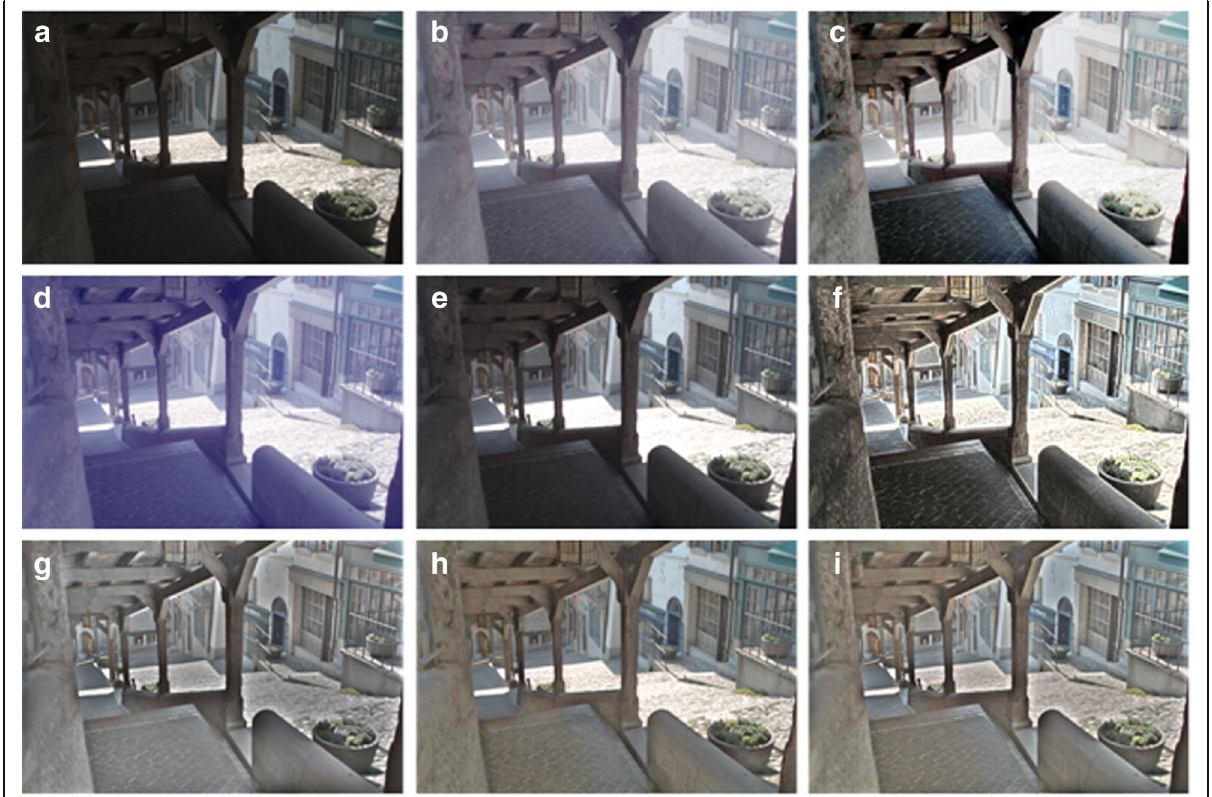
Fig. 6 Experimental results on passage. a Original image; b MSR; c LHE; d AL; e ALTM; f GUM; g SARV; h NPE; i